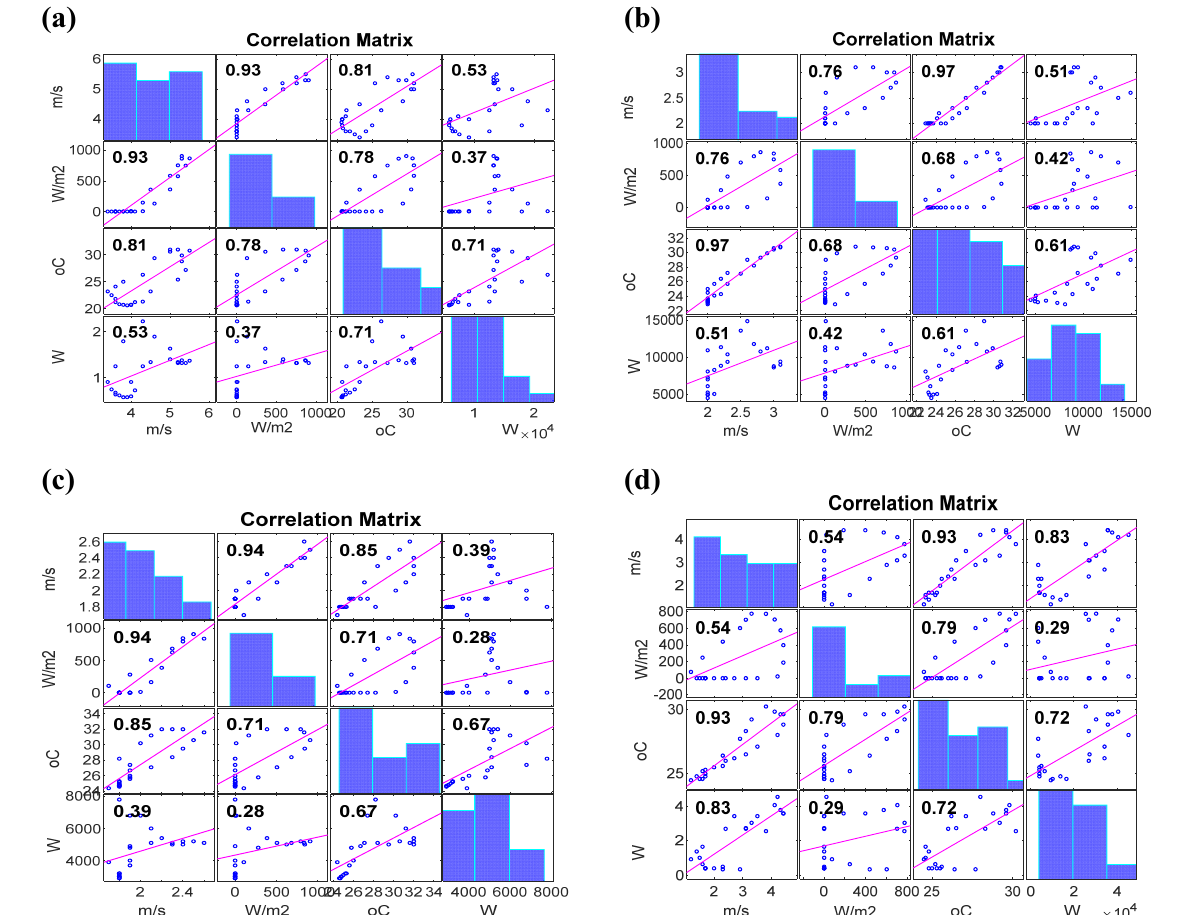
Figure 6. Correlation matrices between the variables for ( a ) Kano, ( b ) Abuja, ( c ) Niger, and ( d ) Lagos.